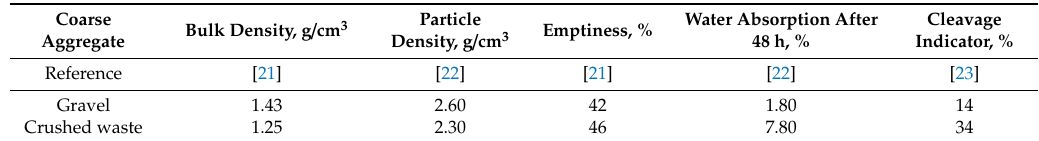
Table 1. Main coarse aggregate characteristics.